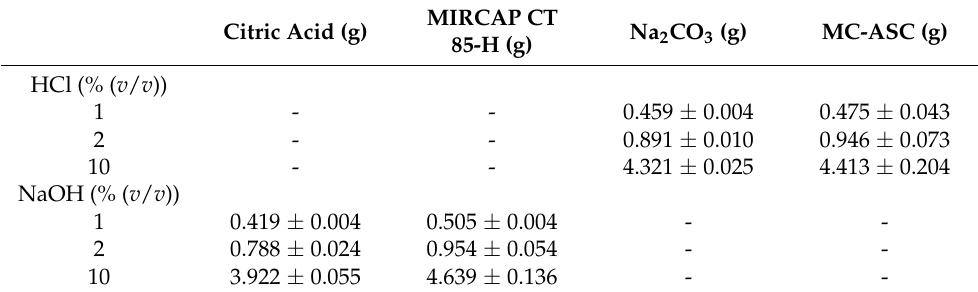
Table 1. Compounds mass needed for complete neutralization of 25 mL of hydrochloric acid (HCl) and sodium hydroxide